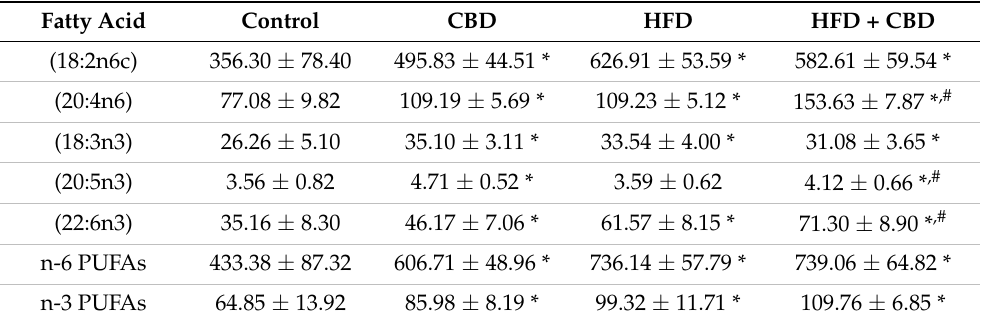
Table 2. Polyunsaturated fatty acids (PUFA) content in the FFA fraction (nmol/g of wet tissue) in the red gastrocnemius muscle in the control (standard diet) and high-fat diet (HFD) groups after two-week cannabidiol (CBD)